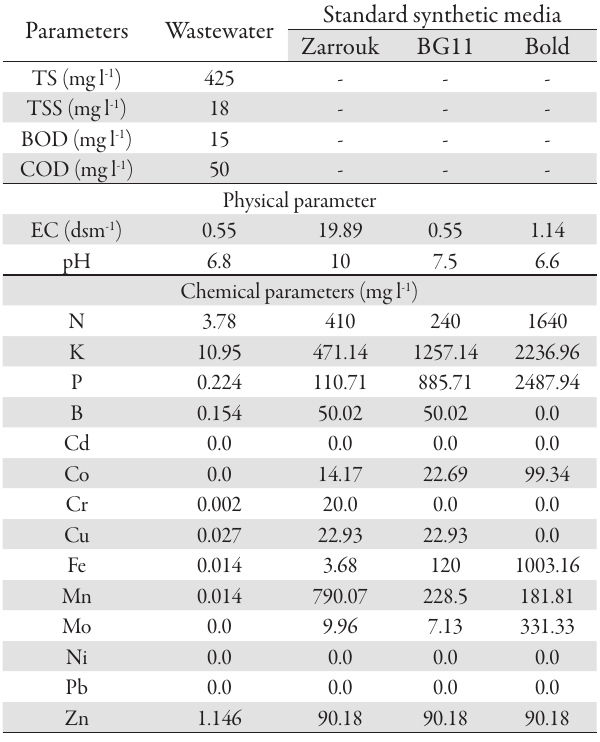
Tab. 2. Chemical analyses of the initial domestic wastewater comparing with the algal synthetic media (Zarrouk, BG11 and